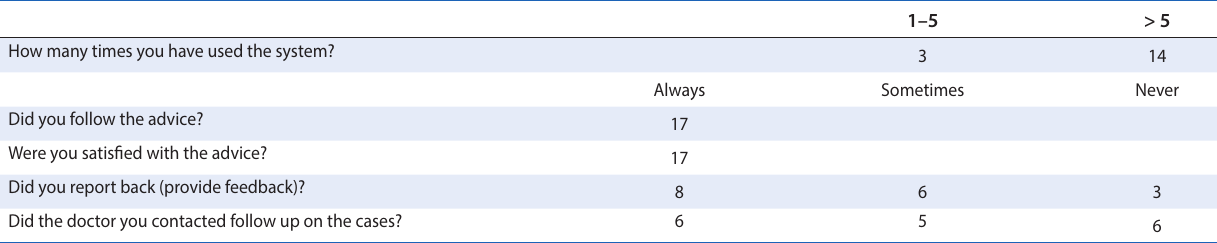
Table 1: Frequency of use and perceived utility of the telephonic support